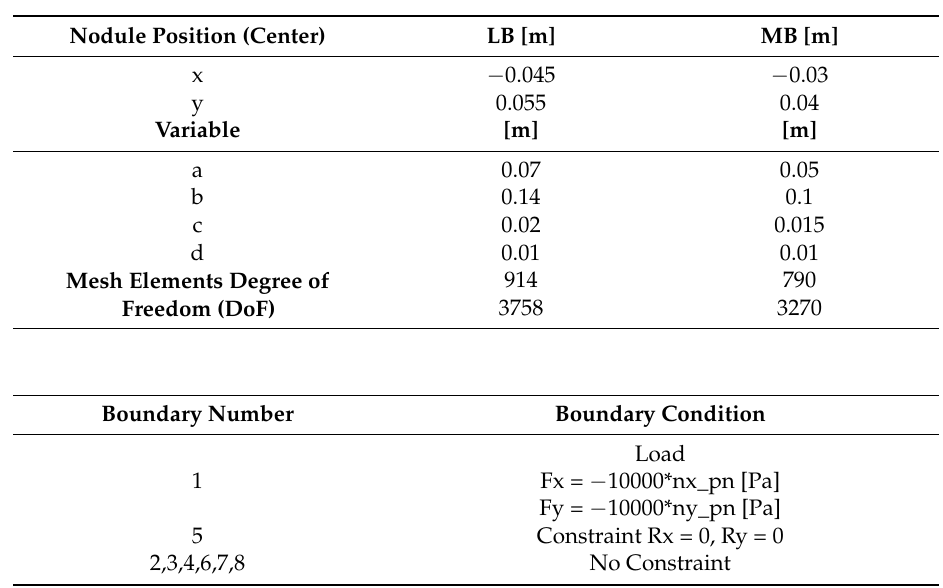
Figure 4. Two-dimensional (2D) model with 10-mm diameter inclusion embedded in breast tissue (large breast, LB). Blue numbers indicate the boundary of the breast, while red letters define the breast’s dimensions. A description of the parameters is given in Table 1. Table 1. Model parameters for the 2D finite element (FE) analysis. The expressions “nx_pn” and “ny_pn” are internal variables of COMSOL to describe the normal direction with respect to the indicated boundary.